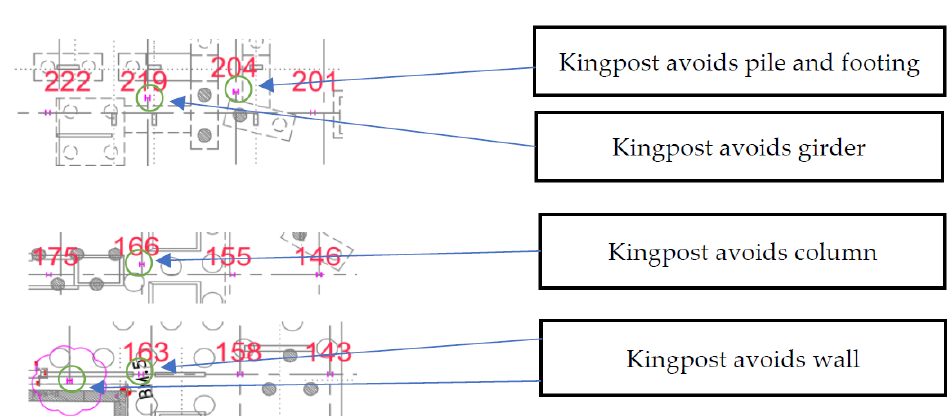
Figure 2. Kingpost plan.